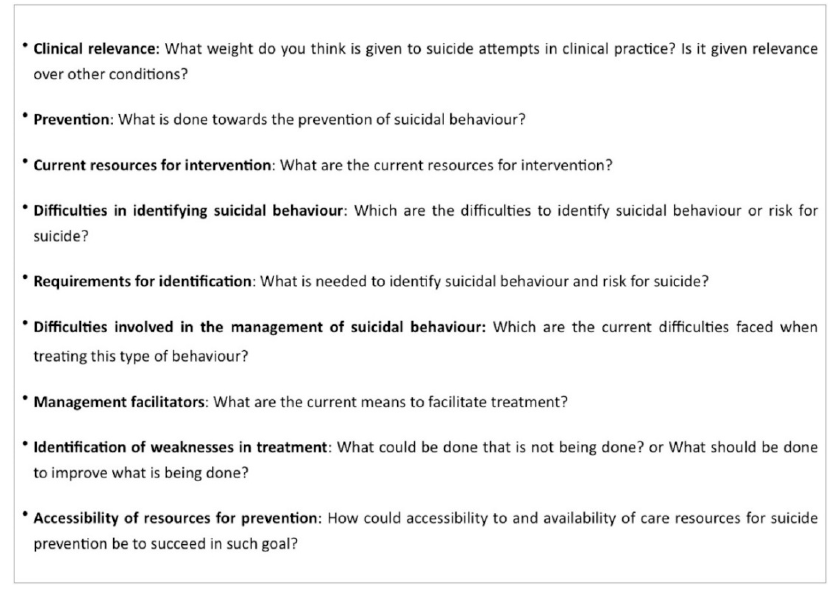
Figure 1. Thematic script for the healthcare professionals’ focus group sessions.